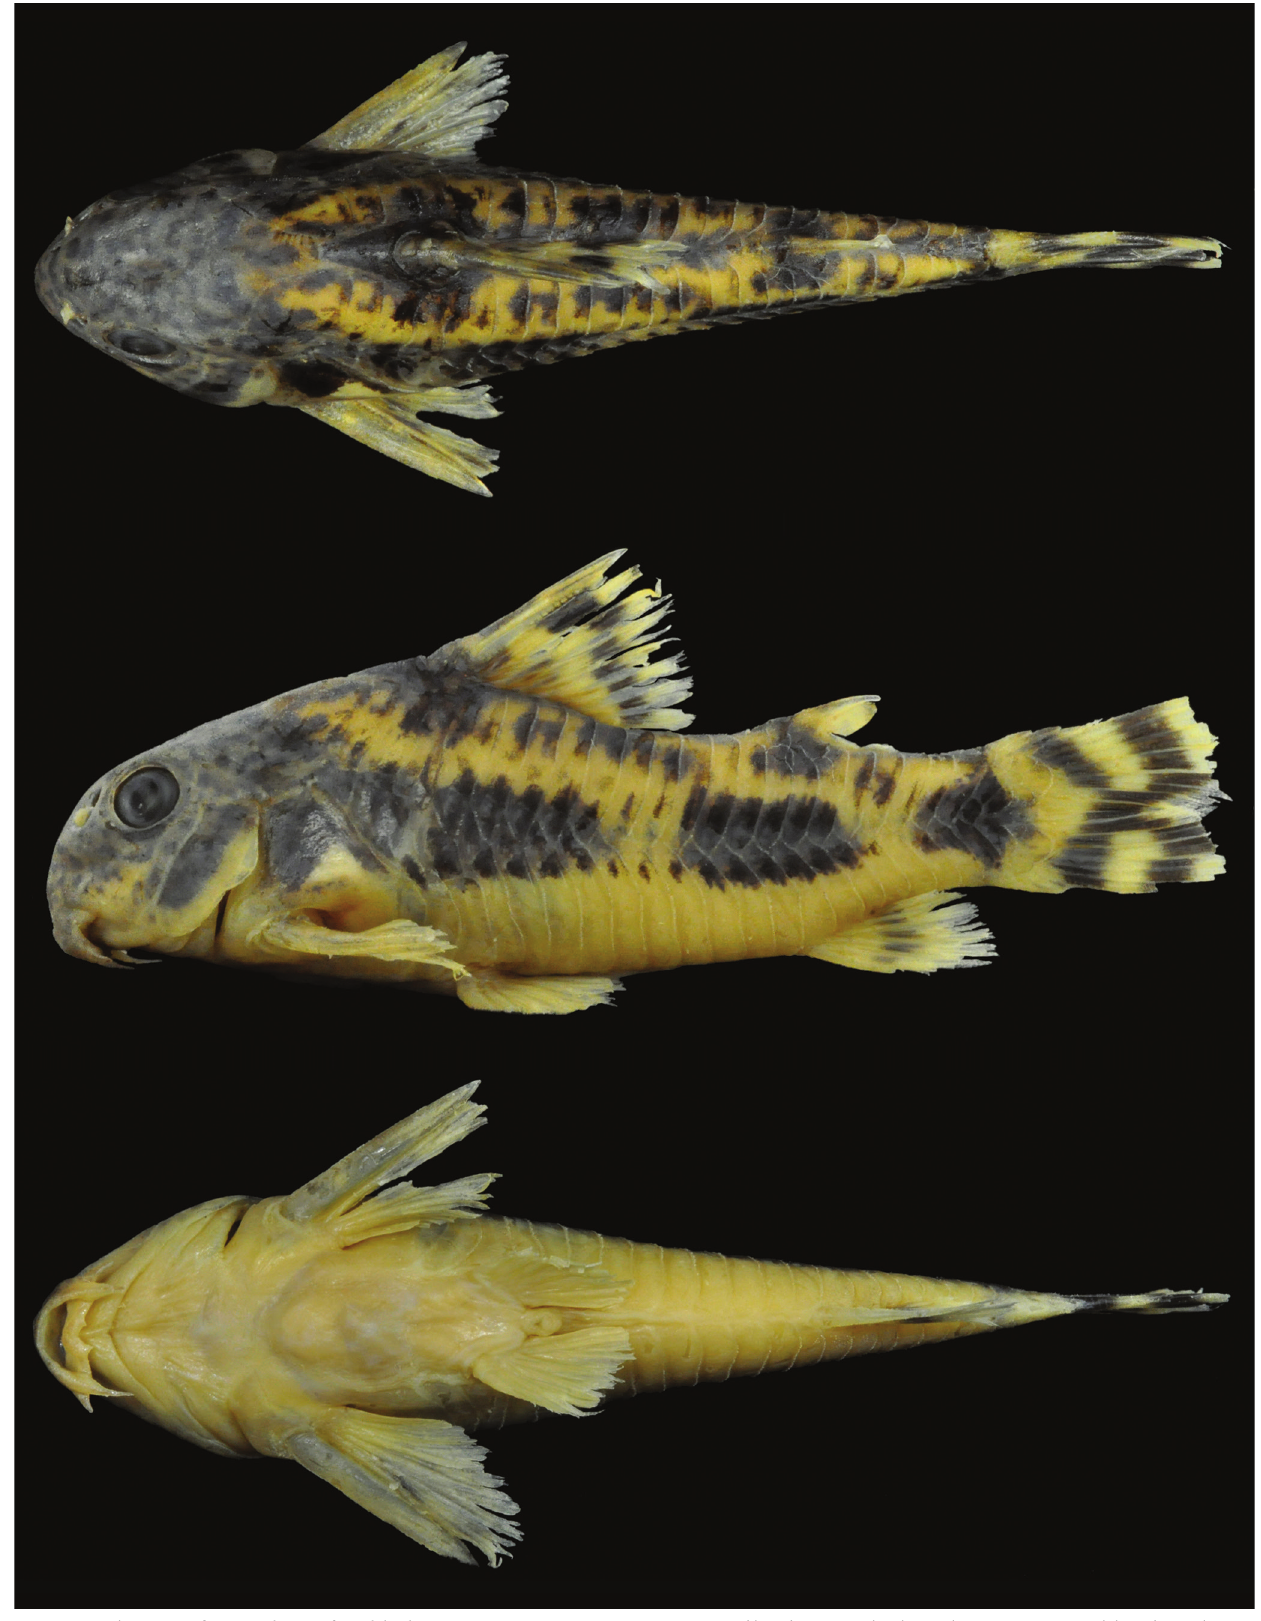
Fig. 8. Holotype of Corydoras froehlichi , MCP 48433, 51.5 mm SL, Brazil, Rio Grande do Sul State, Esmeralda, rio Pelotas, upper rio Uruguai basin. Dorsal, lateral and ventral